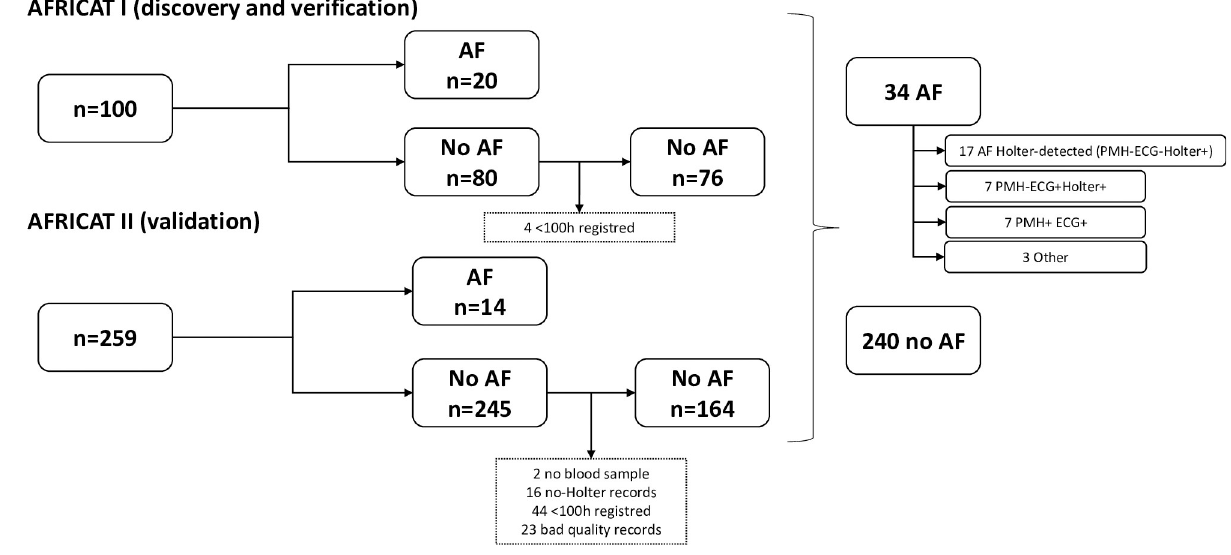
Fig 1. Flow chart of the AFRICAT